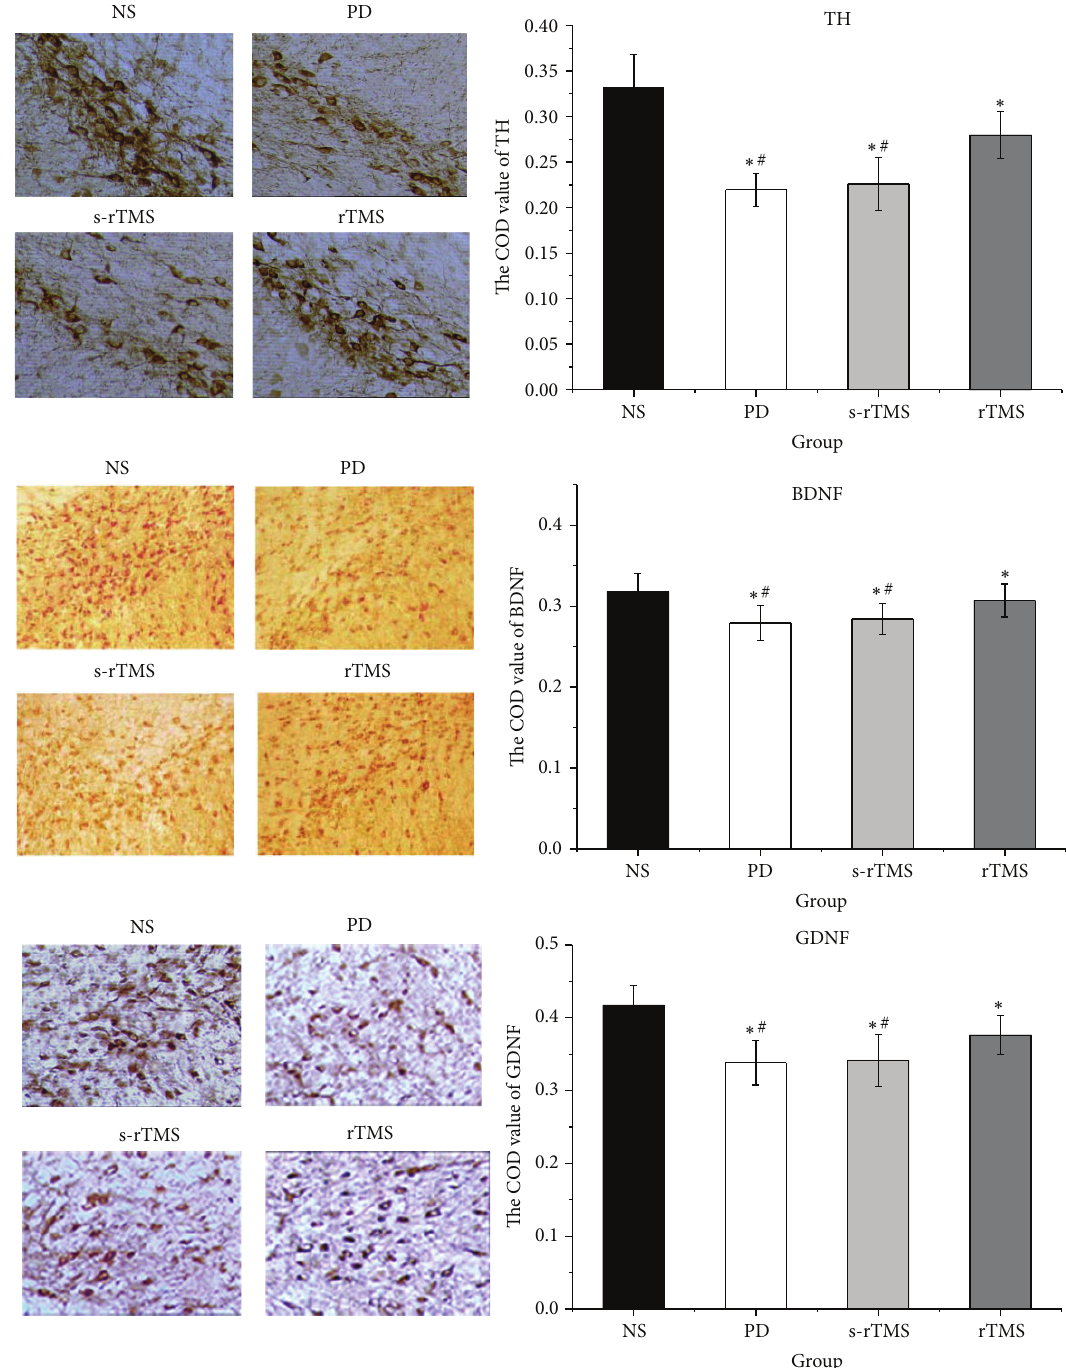
Figure 5: The effect of low-frequency rTMS on the expression of TH, BDNF, and GDNF as illustrated by immunohistochemical staining. ∗ Significantly different from NS group, 𝑃 < 0.05 ; # significantly different from rTMS group, 𝑃 < 0.05